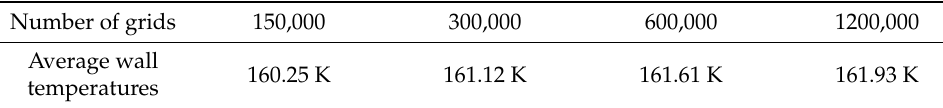
Table 2. Average wall temperature under four sets of